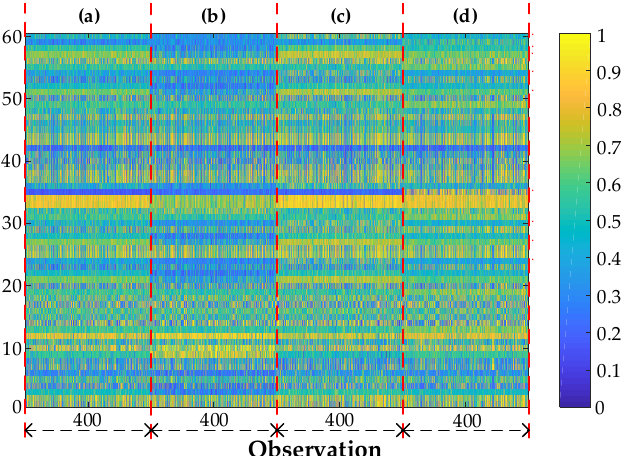
Figure 4. The MRA of current signal. ( a ) Normal motor, ( b ) bearing fault, ( c ) interturn short circuit, ( d ) broken rotor bar.